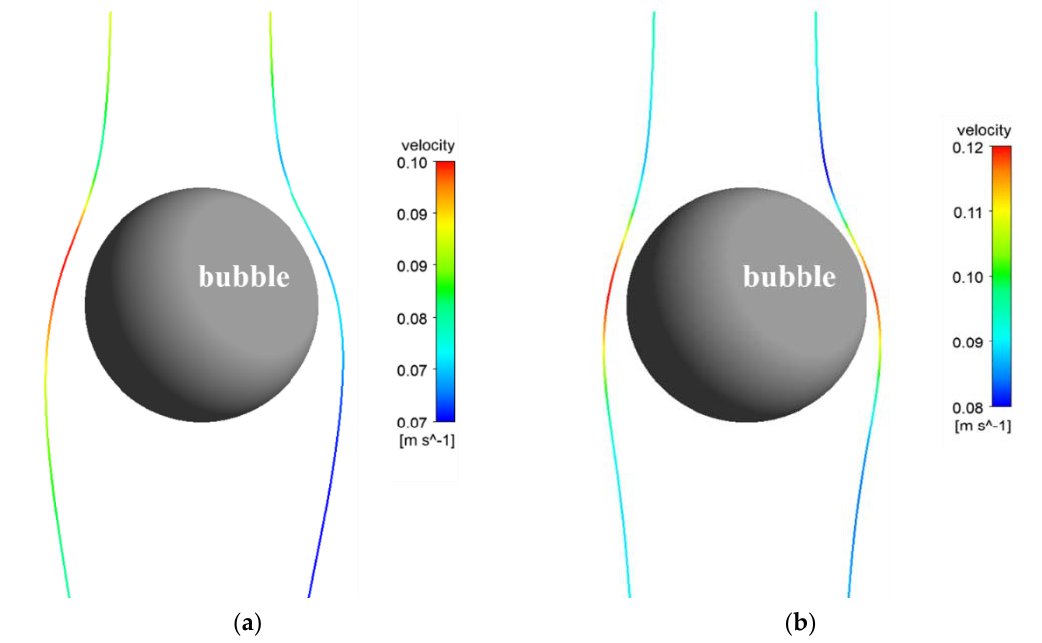
Figure 9. Particle tracks with velocity for bubble diameter of 0.9 mm and galena particle diameter of 150 μm ( a ) immobile surface; ( b ) mobile surface.